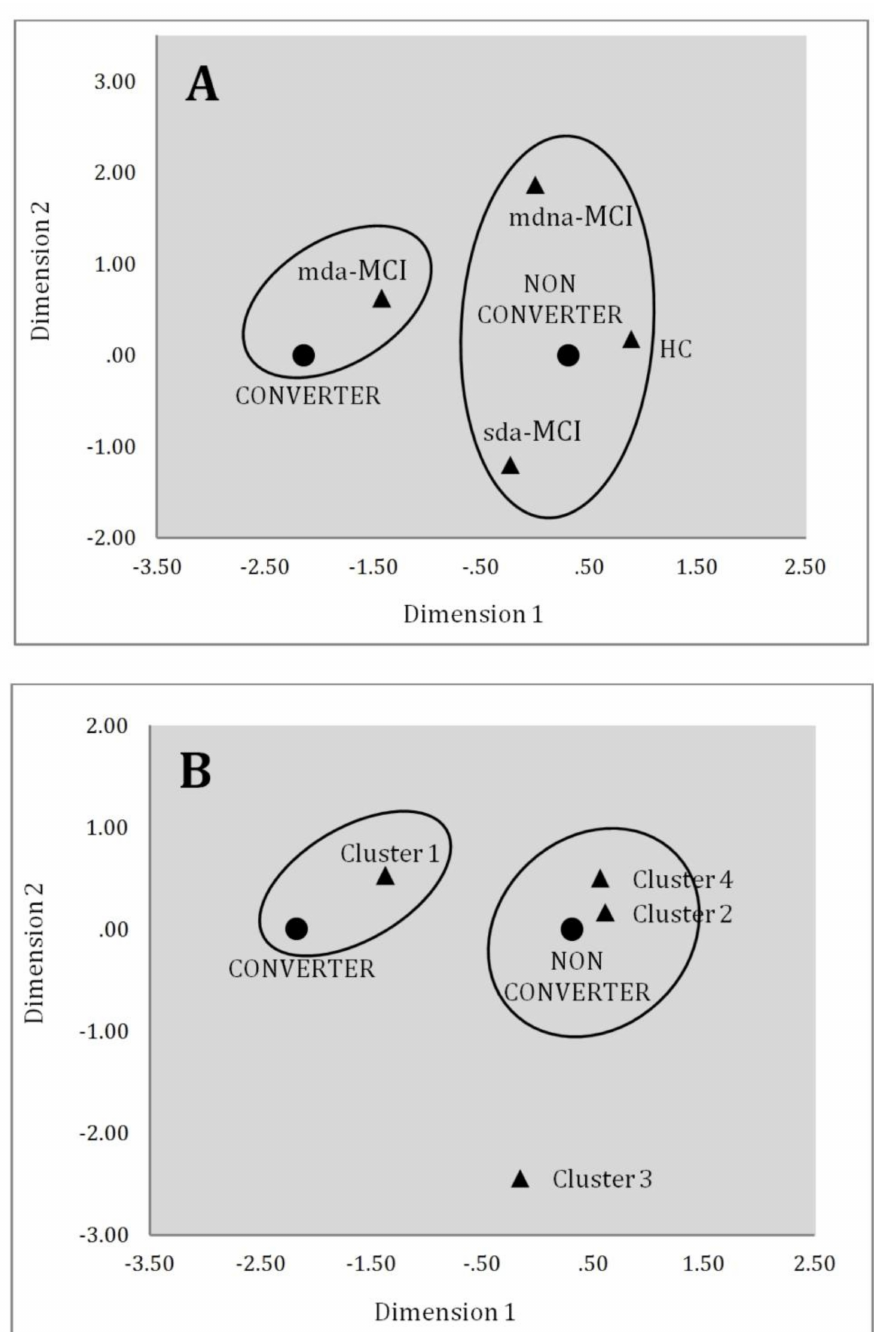
Figure 2. Scatter plot of category points in the multiple correspondence analysis for the associations between evolution of dementia and general impairment in the clinically diagnosed groups ( A ) and the clustering solution ( B